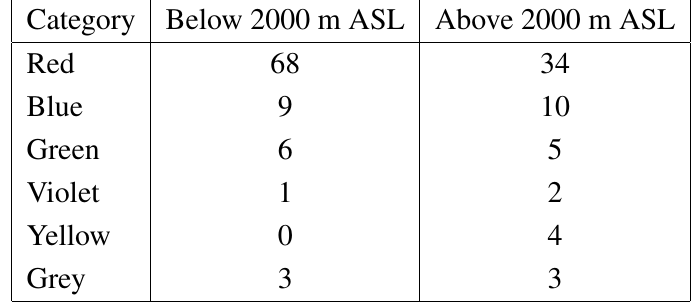
Table 2. Number of simulation points in the Alps above and below 2000 m ASL for each category as defined in Table 1 (the total number of Alpine points is